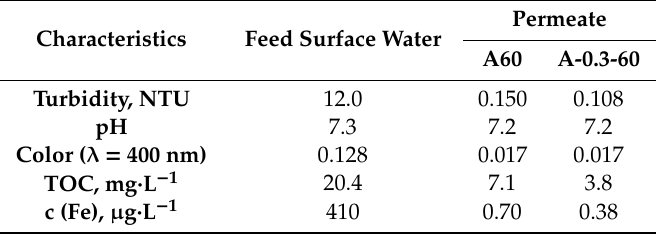
Table 5. Characteristics of feed surface water and